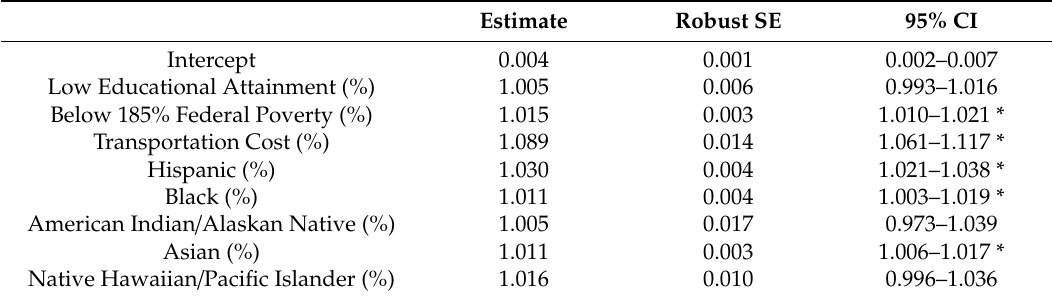
Table 3. Results of multivariate model of COVID-19 test positivity based on SES and race / ethnicity variables. Estimates and 95% CIs are the exponentiated coe ffi cients of the Poisson model, with statistically significant associations indicated with an